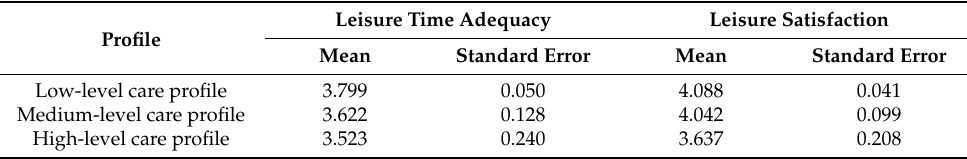
Table 6. Leisure attributes by